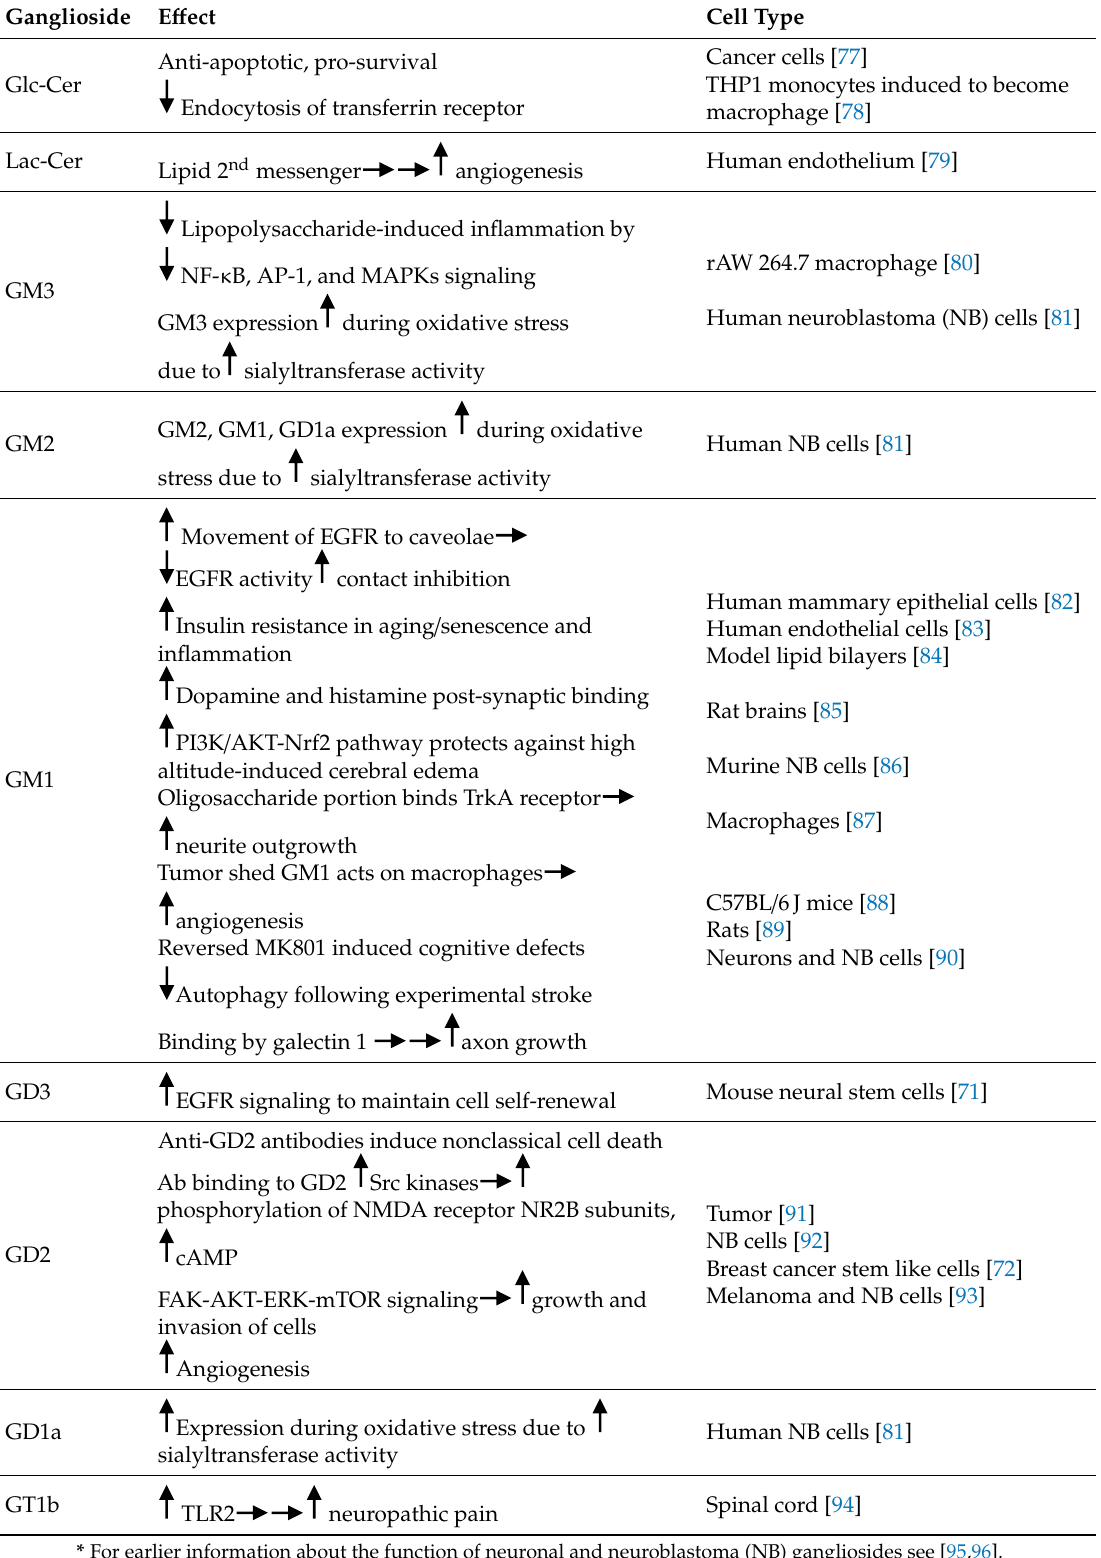
Table 2. Examples of controls of activity of enzymes needed for synthesis of neural gangliosides from ceramide.